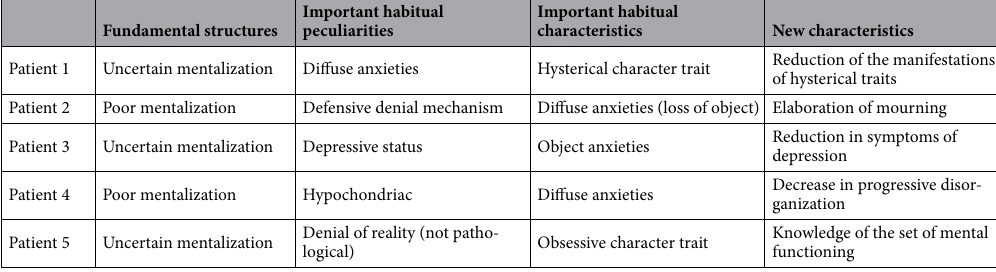
Table 5. Pierre Marty’s nosological